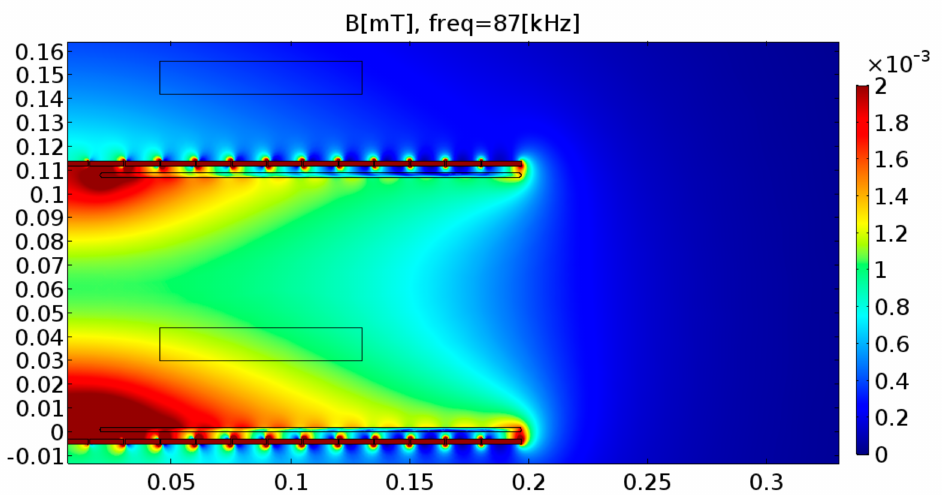
Figure 7. Simulation results of the distribution of magnetic induction within a system of coils (operating frequency, 87 kHz; transmitting power, 1450